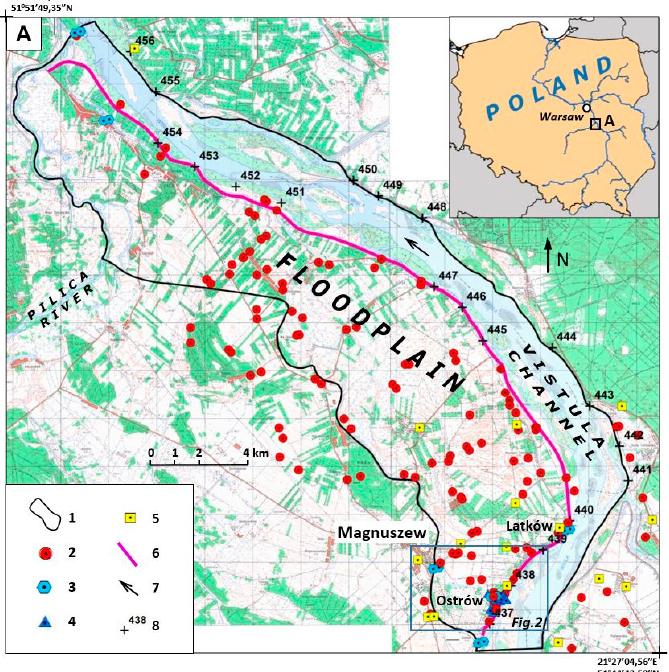
Figure 1. Location of the study area with the arrangement of documentation points. 1—border line of the area, 2—drillings, 3—water gauge, 4—wells, 5—archive drillings, 6—embankment, 7—Vistula flow direction, 8—kilometer of the river.